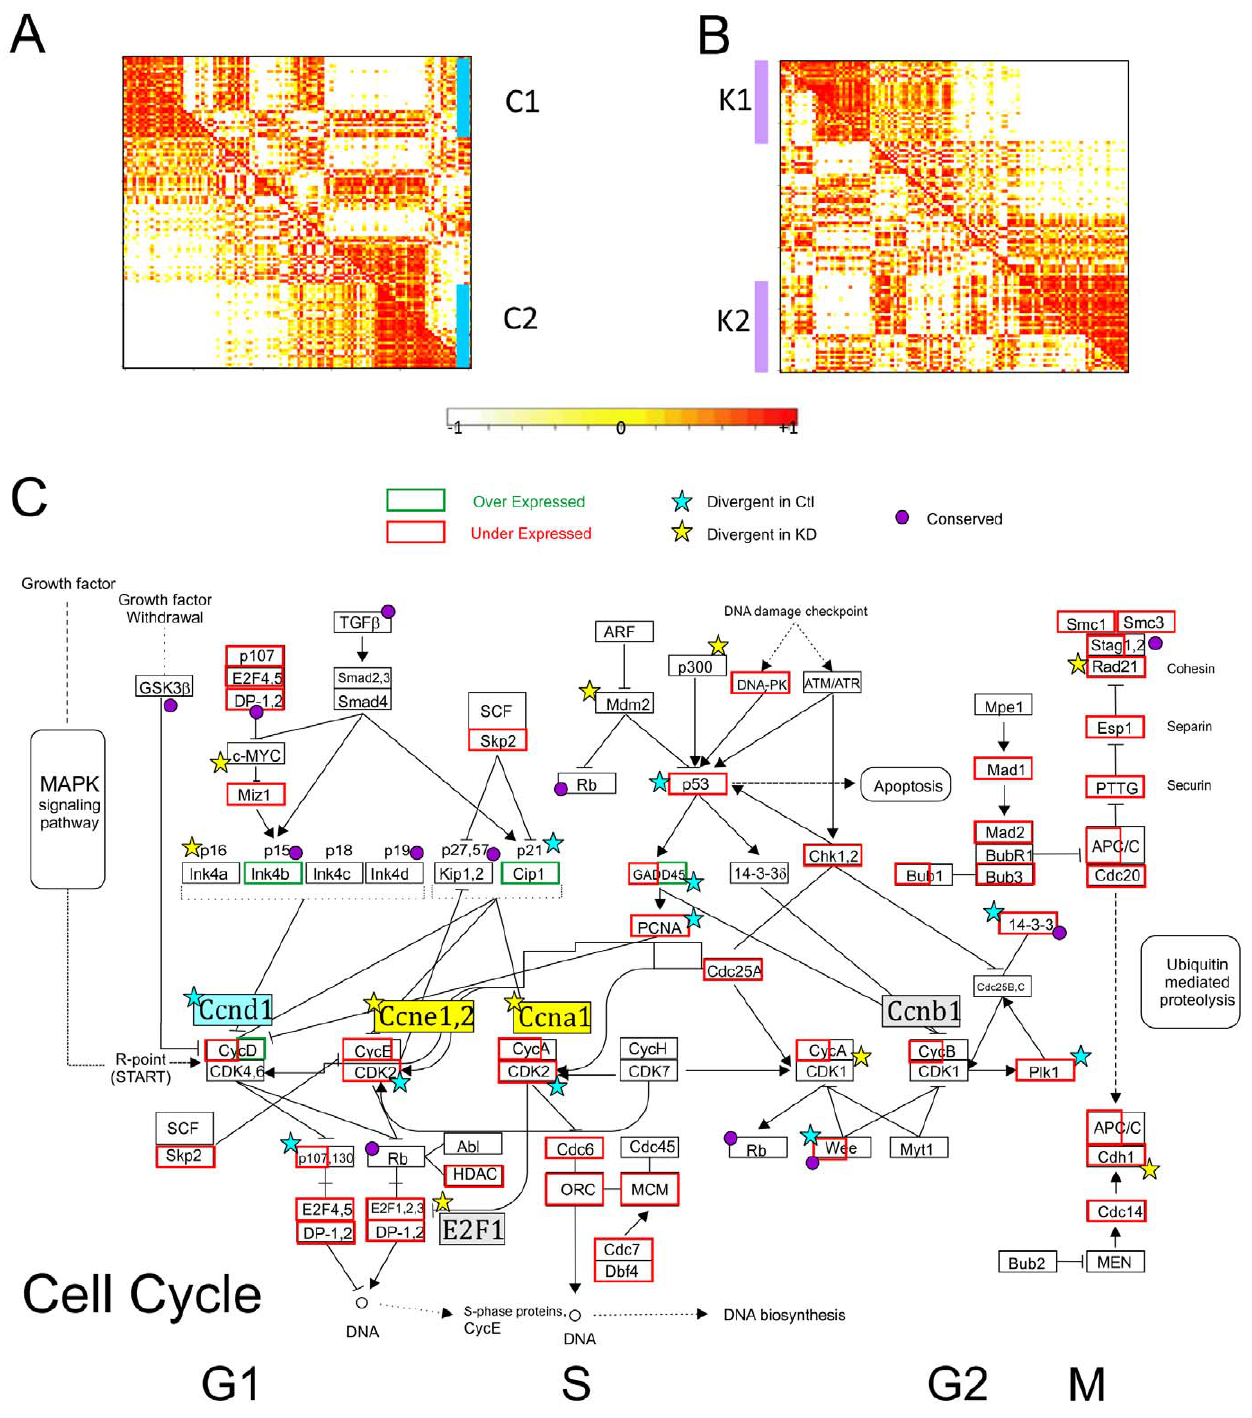
Figure 4. Identification of conserved and divergent co-expression gene clusters in the cell cycle. A) Graphic representation of a correlation matrix of genes based on expression profiles in control (the lower-left triangle) and B-MYB knockdown (the upper-right triangle) ESCs. Genes are listed on the horizontal and vertical axes in the same order. Clustering profiles were determined from the correlation of gene expression where control samples were used as the primary reference. C1 and C2 represent co-expression clusters in controls. The light-to-dense color gradient on the graph indicates low-to-high correlations between gene and their expression. B) Clustering analysis based on the correlation of gene expression where B-MYB deficient (knockdown) samples were employed as the primary reference. K1 and K2 represent co-expression clusters in knockdown conditions. C) Core network illustrating expression and co-expression patterns in a KEGG cell cycle pathway.